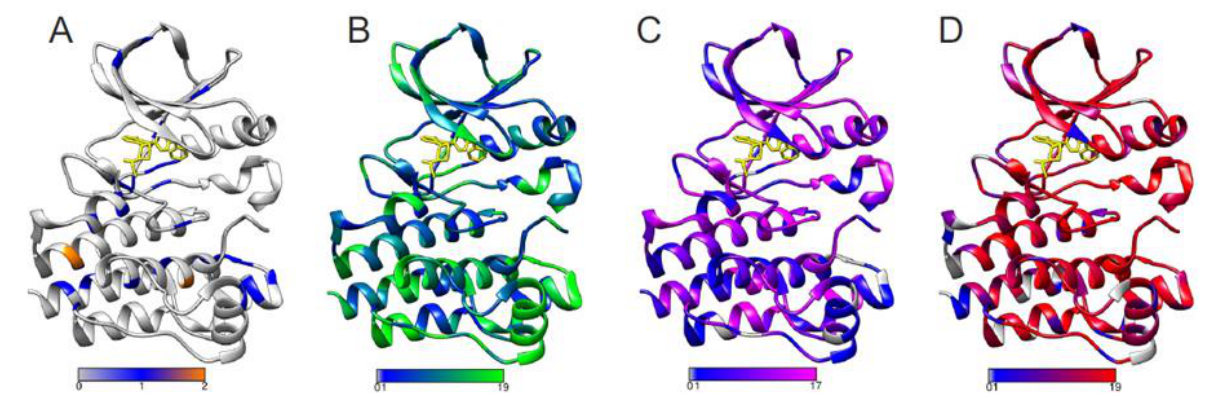
Figure 2. Predicted solubility and disease-related variations in BTK kinase domain (PDB id 5p9j (69), covalent inhibitor at the ATP binding site is in yellow. ( A ) Numbers of variations increasing solubility, ( B ) numbers of variations having no effect on solubility, ( C ) numbers of variants decreasing solubility, and ( D ) numbers of XLA-causing variants. Predictions were made for all 19 single amino acid substitutions at every position. bPathogenicity-related variants were predicted with PON-P2. Keys in the bottom show the numbers of variants predicted to have the effect.